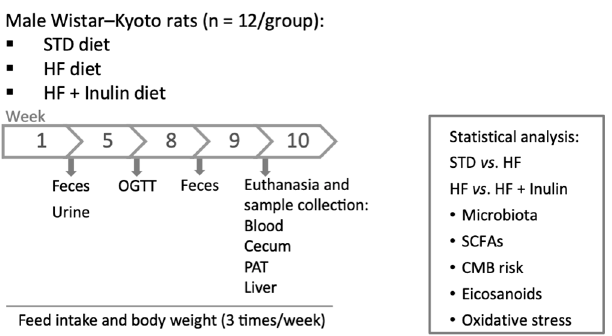
Figure 1. Animal experiment. Abbreviations: STD, standard diet; HF, high-fat diet containing 34% sucrose; HF + Inulin, modified HF diet containing 19% sucrose and 15% inulin; OGTT, oral glucose tolerance tests; PAT, perigonadal adipose tissue; SCFAs, short-chain fatty acids; CMB risk, cardiometabolic risk factors.